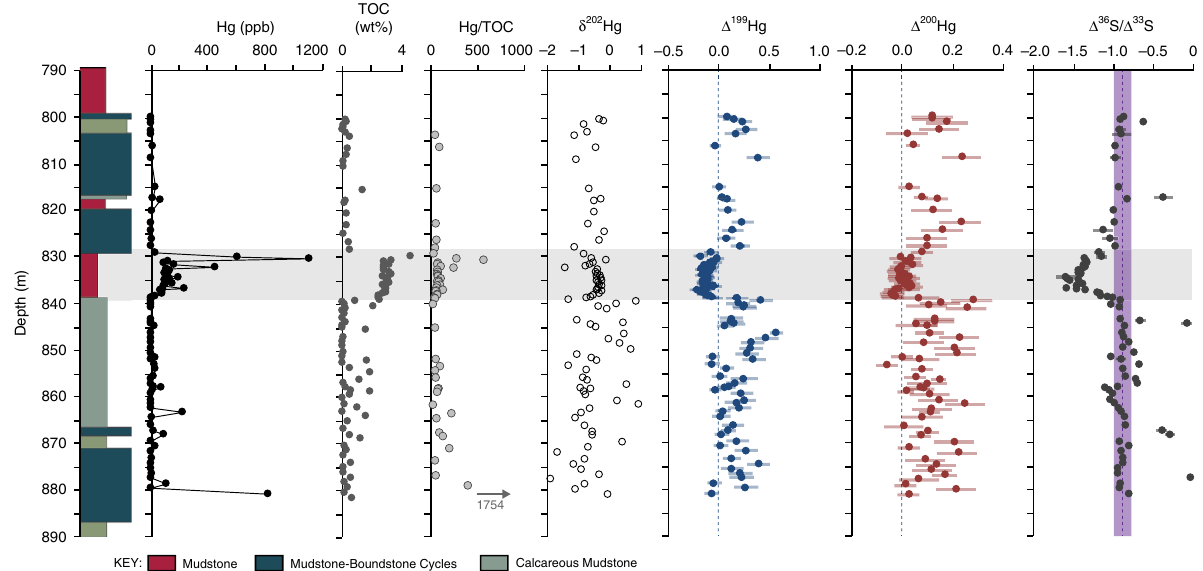
Fig. 1 Lithologic and geochemical data for the studied section. Data are listed in Supplementary Data 1, and include Hg concentrations (ppb), total organic carbon (TOC, wt%), Hg/TOC ratios for samples with TOC > 0.2 wt% (ppb/wt%), Hg isotope values ( δ 202 Hg, Δ 199 Hg, and Δ 200 Hg, in ‰ ), and pyrite S- MIF data ( Δ 36 S/ Δ 33 S; from ref. 26 ). Uncertainties on Hg isotope data correspond to the larger value of either the measurement uncertainty of replicate digests of MESS-2 or the uncertainty of repeated measurements of UM-Almadén. Uncertainty on Δ 36 S/ Δ 33 S was computed from the larger of the internal or external uncertainties associated with the raw Δ 33 S and Δ 36 S data (as previously reported 26 ). Analytical uncertainties for additional data are encompassed within each individual data point. The gray shaded area indicates the interval where changes in Δ 36 S/ Δ 33 S correspond to changes in Hg-MIF values; the vertical purple line illustrates the background Archean Δ 36 S/ Δ 33 S ratio; vertical dashed lines also illustrate 0 ‰ in Δ 199 Hg and Δ 200